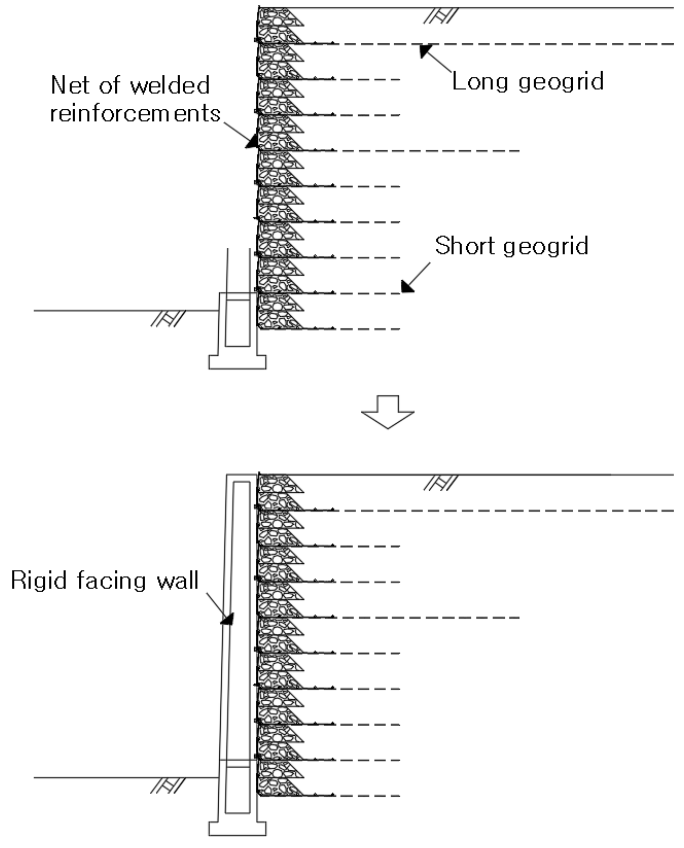
Figure 1. Construction of reinforced subgrade for railways (RSR) [23]. Table 1. Site investigation